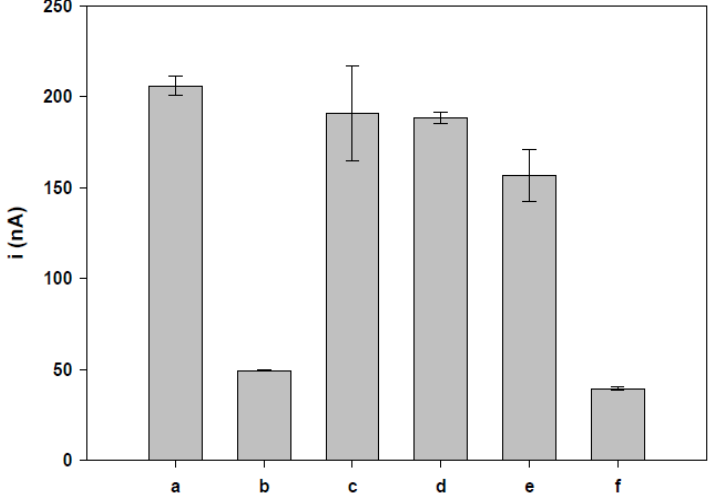
Figure 5. The differential pulse voltammograms of guanine oxidation at (a) TS-1P (1 µM) immobilized on activated PGE before hybridization, (b) TS-1P (1 µM) immobilized on activated PGE after hybridization with complementary TS-1T (40 nM), (c) with PolyG-NC (40 nM), (d) with TS-2 NC (40 nM) (e) with TS-3 NC (40 nM) and (f) mixture of complementary and non-complementary (PolyG-NC, TS-2 NC and TS-3 NC) (40 nM each). Voltammetric conditions: Scanning potential steps, 20m V/s. Potential amplitude, 50